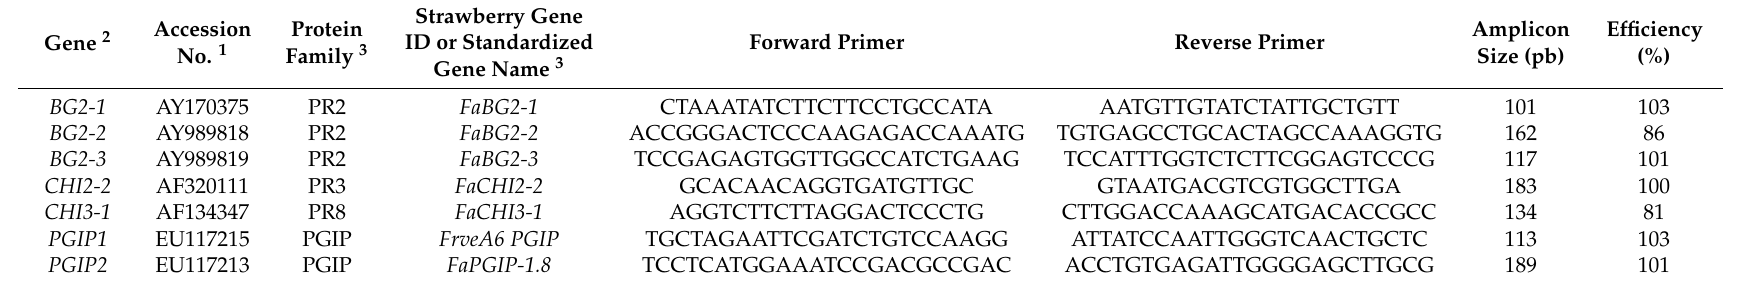
Table 2. Strawberry defense genes and primers sequences used for the gene expression analysis 1